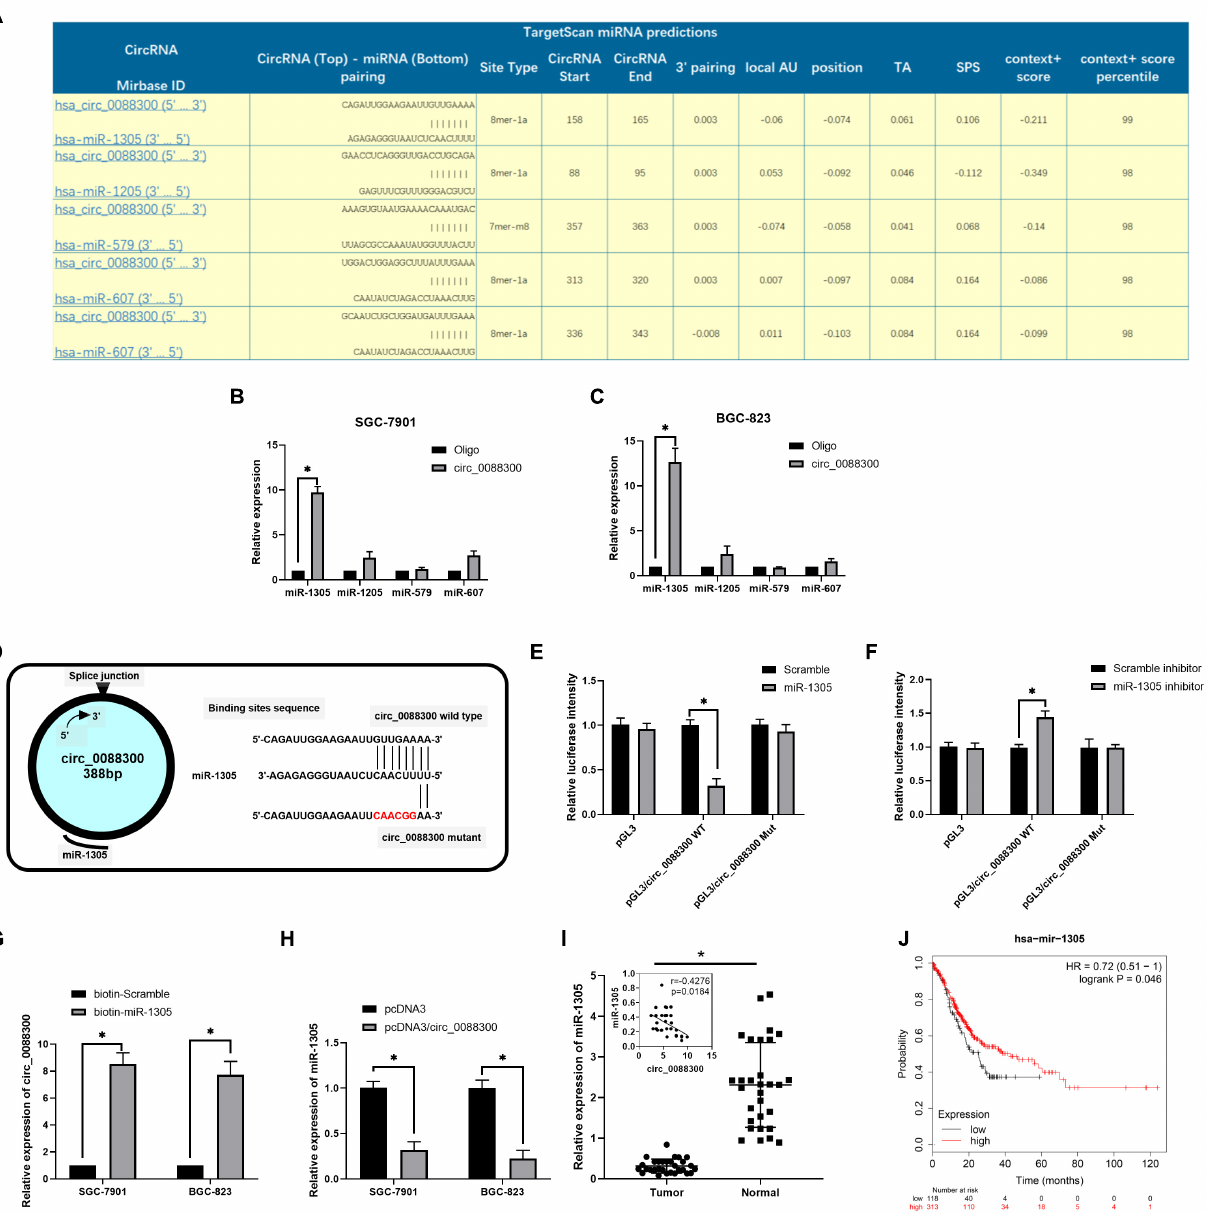
( Supplementary Table 6 ), and the expression of miR-1305 in GC was negatively correlated with circ_0088300 in 30 paired GC tissues ( Figure 6I ). The survival curve also showed that GC patients who exhibited high circ_0088300 expression had a